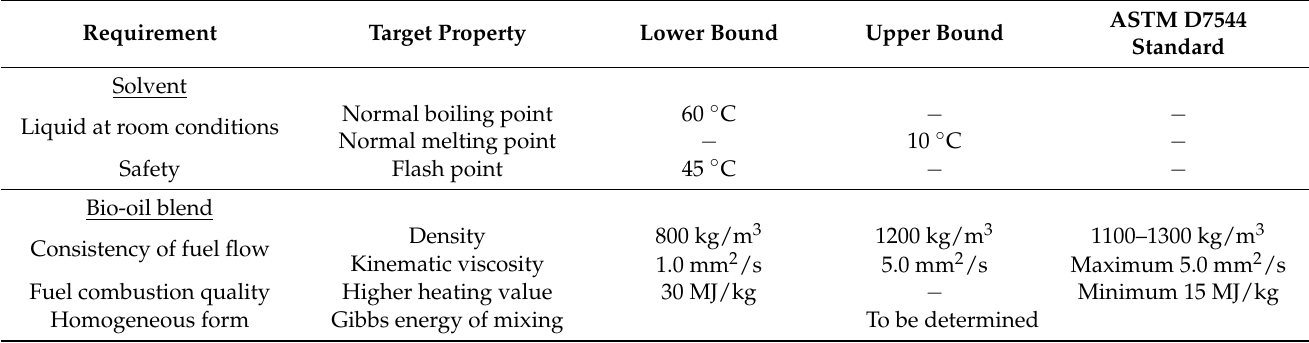
Table 1. Target properties identified and their respective